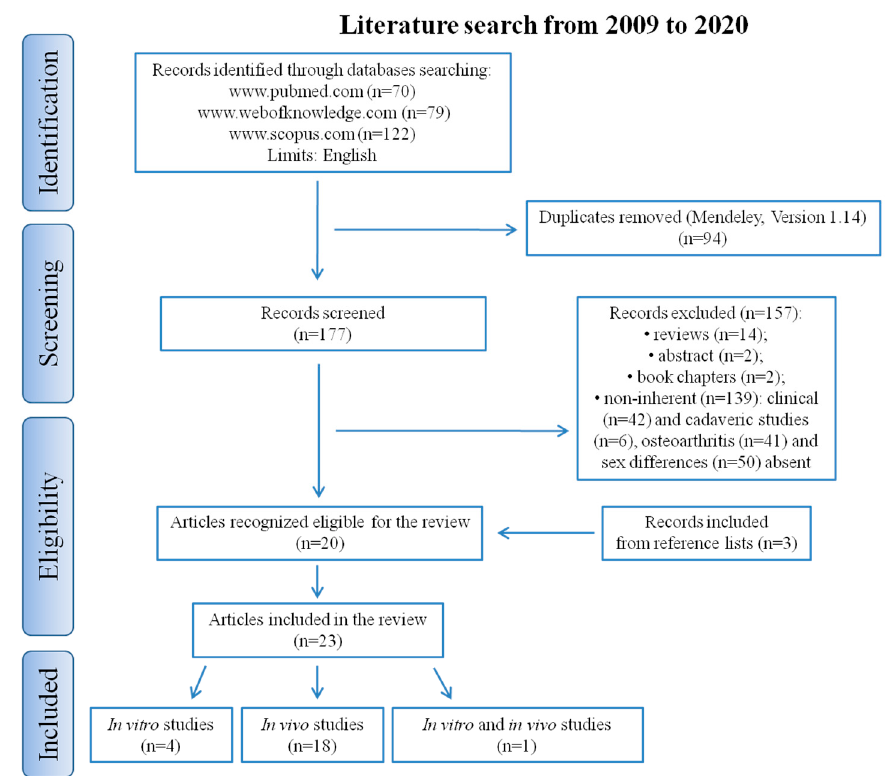
Figure 1. Search strategy according to Preferred Reporting Items for Systematic Reviews and Meta-Analyses (PRISMA) guidelines.